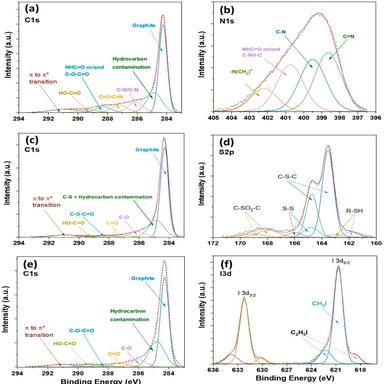
High resolution experimental and fitted XPS spectra of the N-graphite for C1s (a) and N1s (b); spectra of the S-graphite for C1s (c) and S2p (d); and spectra of the I-graphite for C1s (e) and I3d (f).